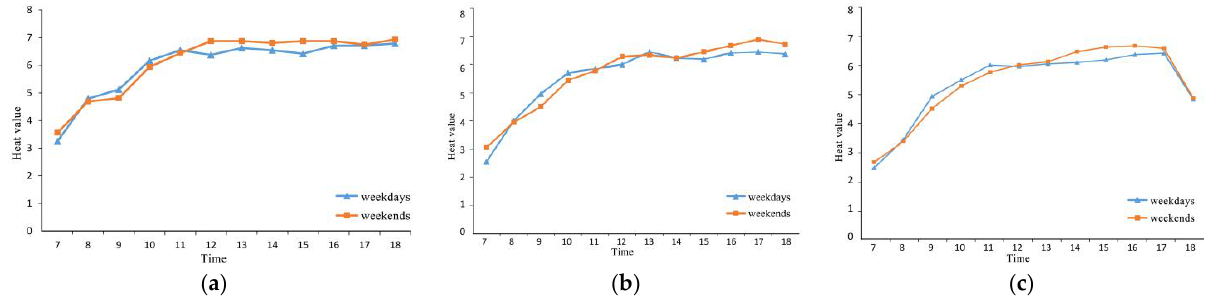
Figure 6. Variation in heat value of tourist flow between weekdays and weekends for the three spatial samples: ( a ) for the “ Cross-shaped ” spatial sample, ( b ) for the “ T-shaped ” spatial sample, and ( c ) for the 1 “ One-character shaped ” spatial